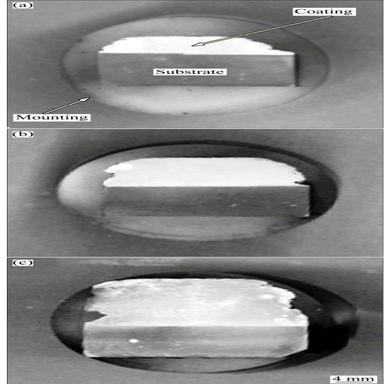
ptical macrographs of AA2124/4wt.%B4C coatings on Ti−6Al−4V alloy at different rotational speeds: (a) 600 r/min; (b) 800 r/min; (c) 1000 r/min